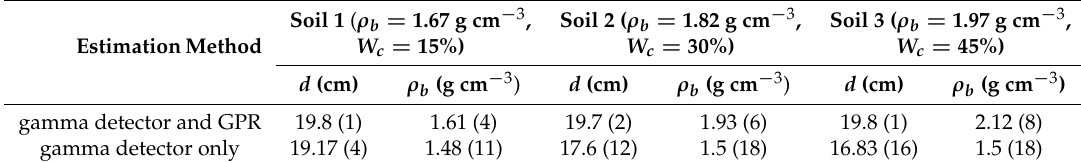
Table 2. Depth and density estimates for a disk source of radius 3 cm buried at a depth of 20 cm in three different soil conditions. The values in parentheses are the relative error in percentage.